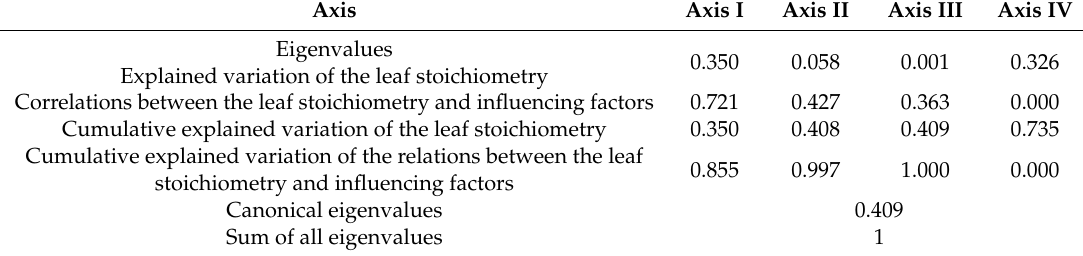
Table 2. RDA analysis (redundancy analysis) of the leaf N and P stoichiometry.